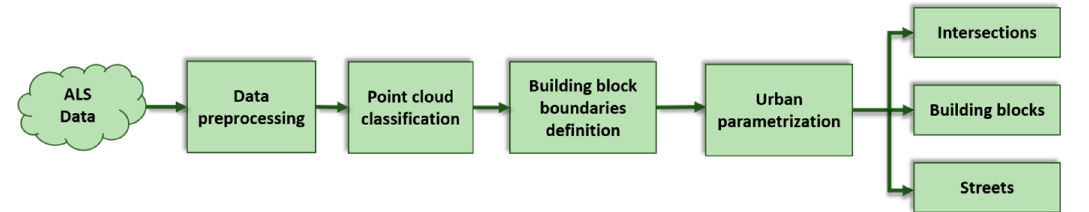
Figure 1. Methodology workflow.